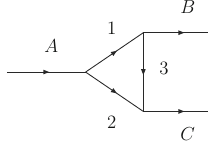
Fig. 1 Feynman diagram for the reaction A → BC source of the triangle singularity (TS) phenomena